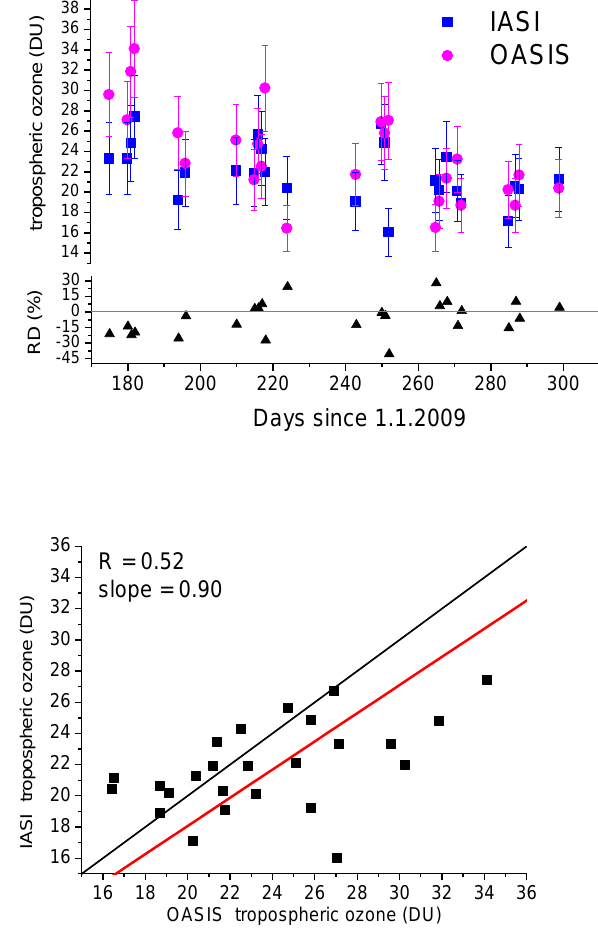
Fig. 4. Upper plot: times series of tropospheric ozone columns de- rived from IASI (blue squares) and OASIS (pink circles). Error bars Figure 4: Upper plot: Times series of tropospheric ozone columns derived from IASI (blue 339 related to OASIS and IASI tropospheric ozone uncertainties are in- squares) and OASIS (pink circles). Error bars related to OASIS and IASI tropospheric ozone 340 dicated. Relative differences (RD) in % (black triangles) are also indicated. Lower plot: tropospheric O 3 columns derived from IASI uncertainties are indicated. Relative differences (RD) in % (black triangles) are also indicated . 341 measurements as a function of OASIS data. Red line is a linear fit Lower plot: tropospheric O 3 columns derived from IASI measurements as a function of 342 with zero OASIS data. Red line is a linear fit with zero intercept. 343